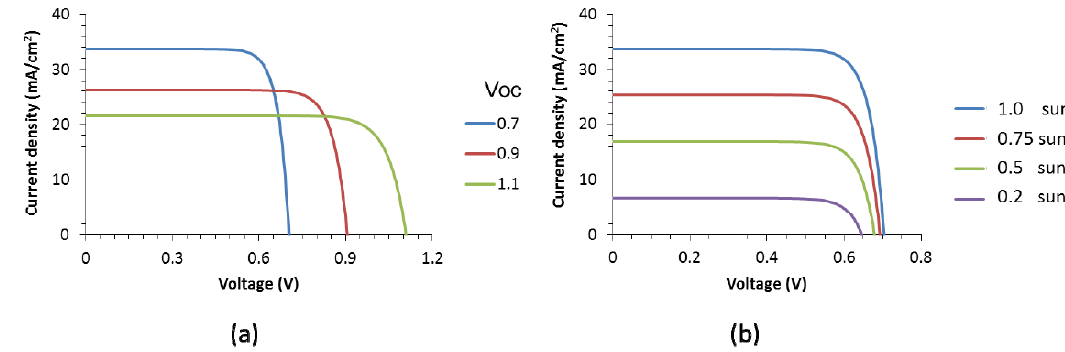
Figure 2. I ‐ V characteristics used for the study ( a ) cells of 19% efficiency with different open circuit voltages (in V, see legend); and ( b ) cell with a Voc of 0.7 V for different light intensities (see legend) in which one sun is equivalent to 1000 W/m 2 ).